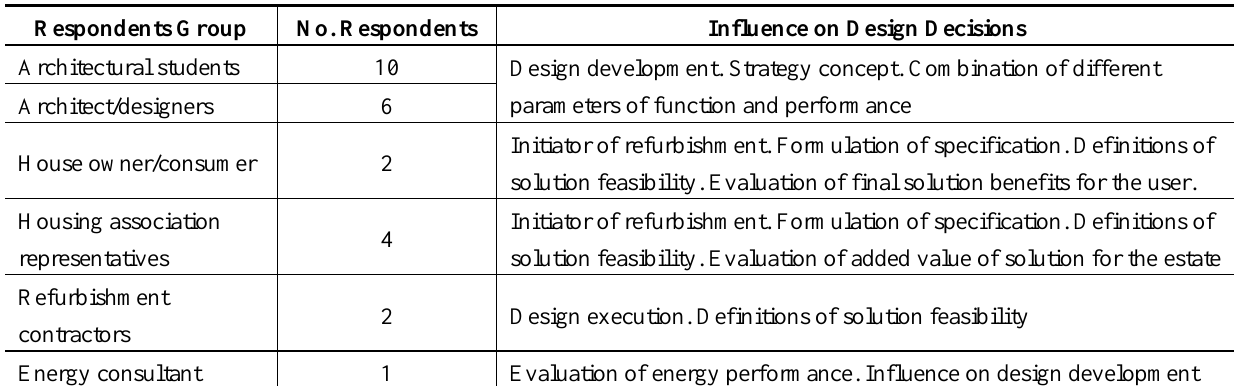
Table 4. Respondent groups